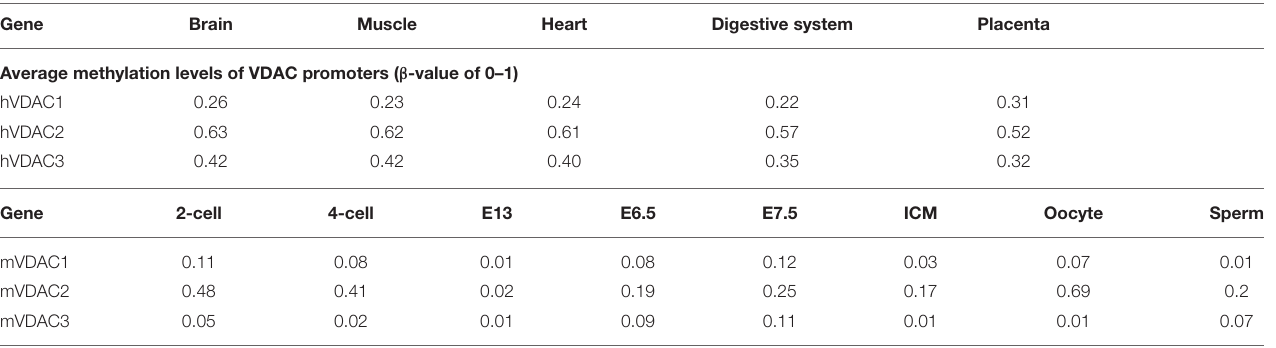
TABLE 3 | Average methylation levels of VDAC genes across different normal human and murine samples from single-based resolution methylomes (SRMs) provided by MethBank (v.4.1). Gene Brain Muscle Heart Digestive system Placenta Average methylation levels of VDAC promoters ( β -value of 0–1) hVDAC1 0.26